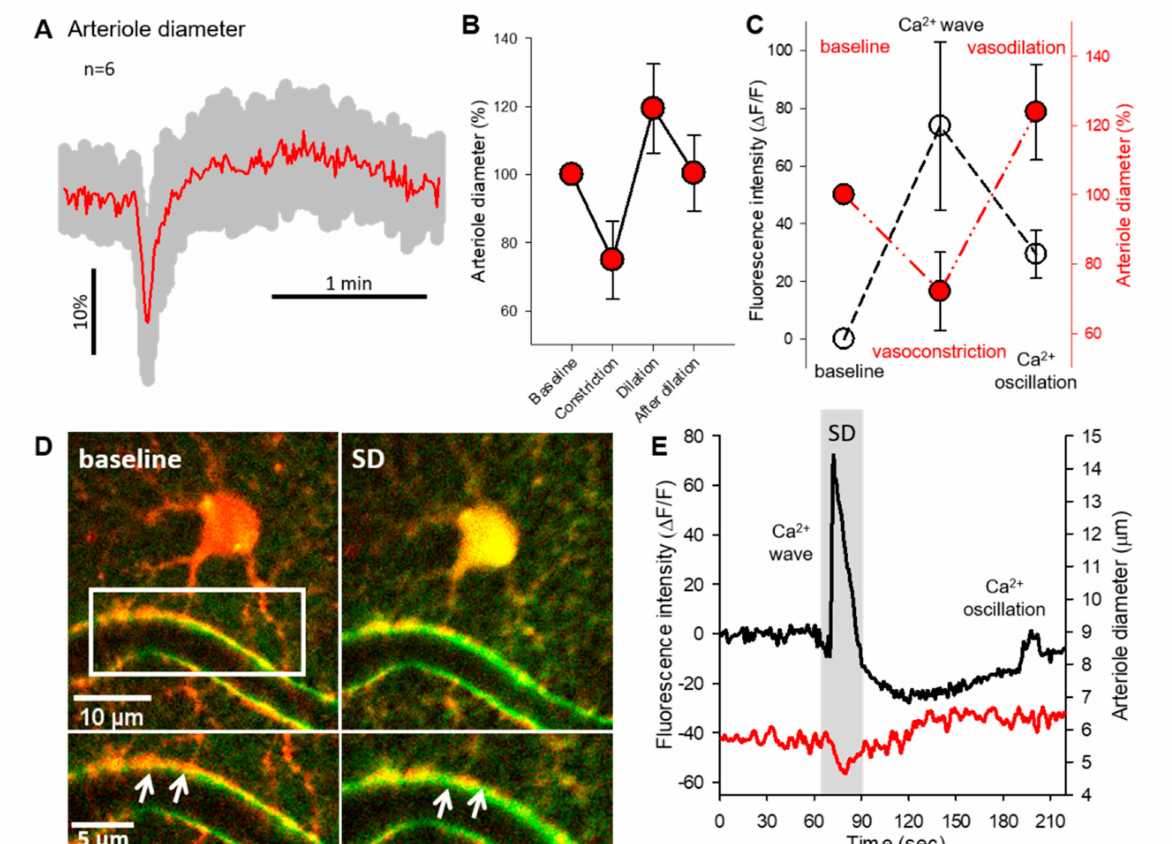
Figure 3. Characterization of arteriole diameter changes associated with astrocyte Ca 2+ events. ( A ) Normalized vessel diameter changes (mean ± st.dev.) associated with SD. ( B ) Absolute and relative variations of arteriolar diameter coupled to SDs. ( C ) Concurrent variations of arteriole diameter (expressed in %) and astrocytic Ca 2+ peak fluorescence ( ∆ F/F). ( D ) Representative images demonstrate a cortical astrocyte (red) opposed to the arteriole wall at the baseline condition and during SD. Green fluorescent signal increase labels the Ca 2+ wave of SD. Inserts mark the astrocyte endfeet-vessel wall connection ( D , bottom). White arrowheads depict the increased green, fluorescent signal at the endfoot-arteriolar surface during SD. ( E ) Representative traces of the SD coupled Ca 2+ wave, oscillation (black) and arteriolar response (red). Traces were extracted from the astrocyte soma and nearby arteriole shown in Panel D . Data are given as mean ±